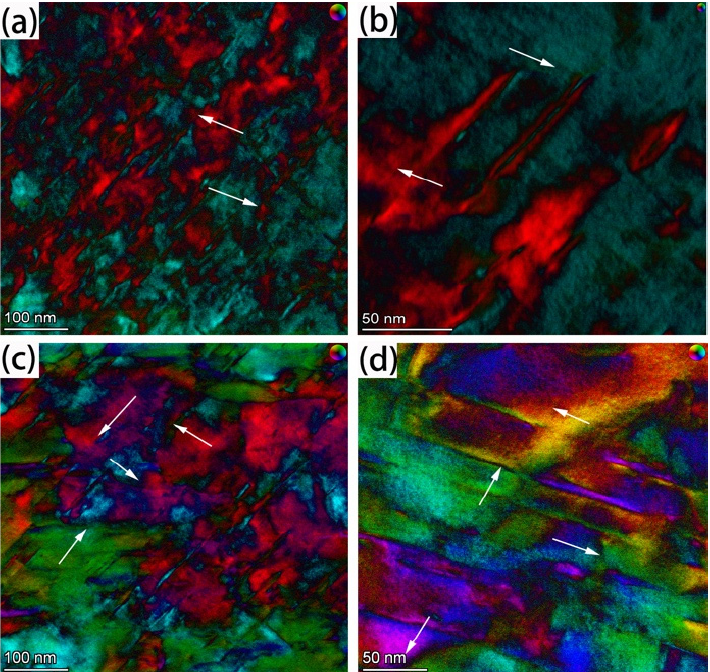
Figure 6. Differential phase contrast (DPC) images of the 0.02PSmN-0.68PMN-0.30PT single crystal under ( a , b ) ACP; ( c , d ) DCP.